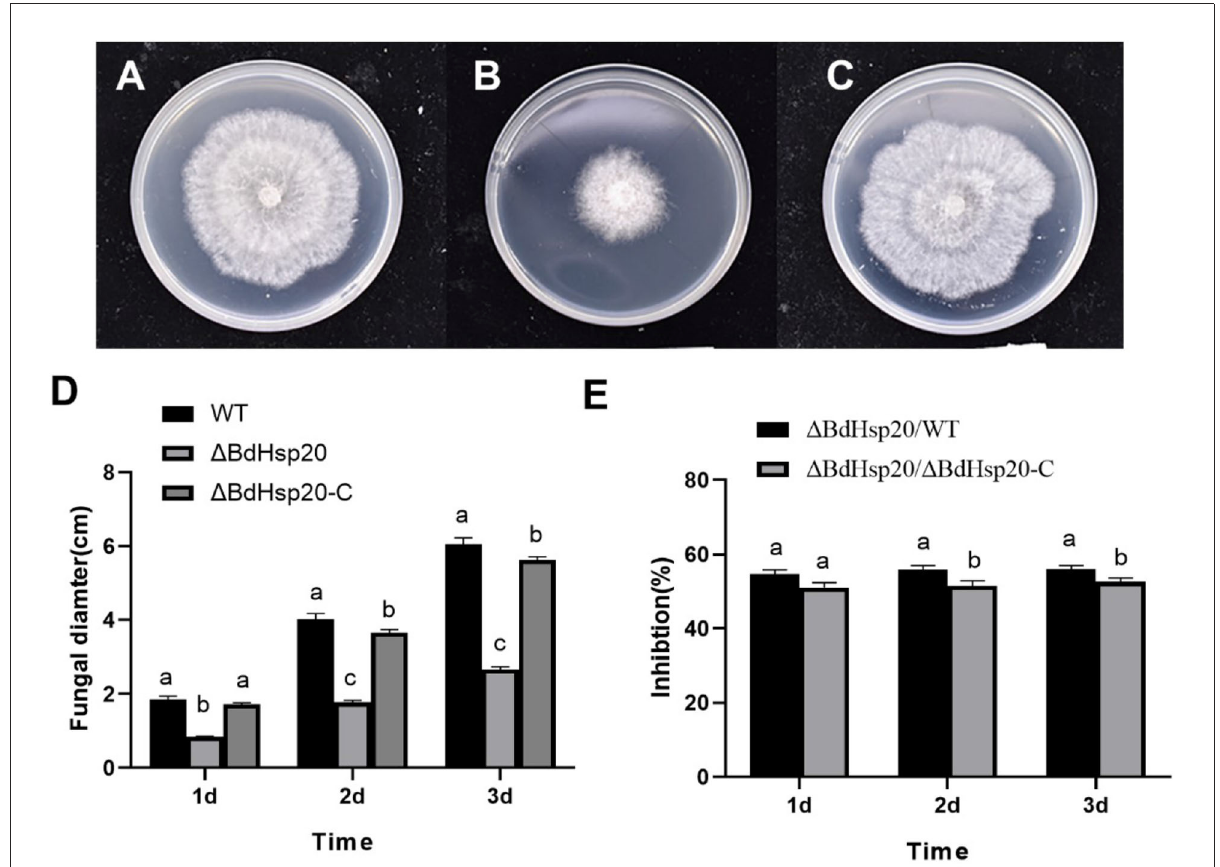
FIGURE8 Mycelial growth of the three Botryosphaeria dothidea strains. The wild-type strain (A) , the CRISPR/Cas9 gene-edited BdHsp20 strain ( 1 BdHsp20) (B) , and the BdHsp20 complemented strain ( 1 BdHsp20_C) (C) were inoculated on a PDA medium for three days. The fungal colony diameters of the three strains were significantly different (D) . Compared to the wild type ( 1 BdHsp20/WT) and the 1 BdHsp20_C (1BdHsp20/1BdHsp20_C), BdHsp20 gene deletion significantly inhibited the mycelial growth of Botryosphaeria dothidea (E) . Lowercase letters indicate significant differences between treatments or times ( P <